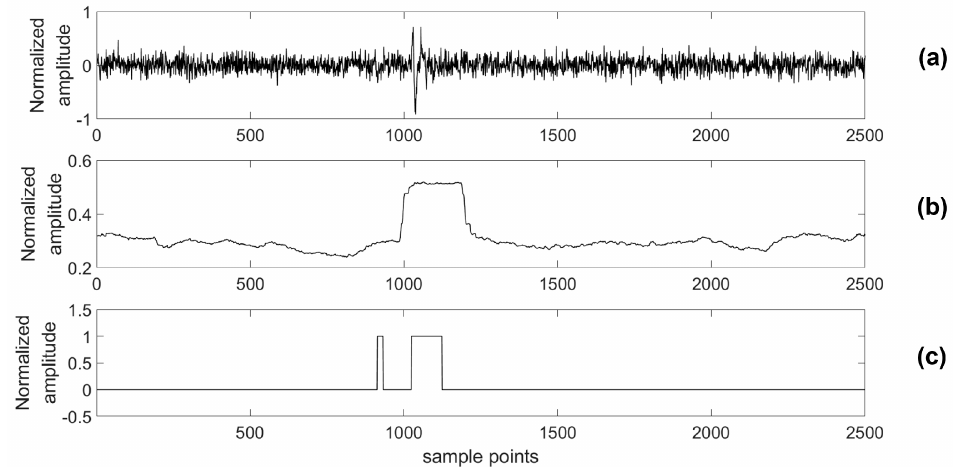
Figure 21. The data with extra noise and its classification results. ( a ) The data with extra noise; ( b ) The classification results of the STA/LTA algorithm; ( c ) The classification results of the proposed algorithm.